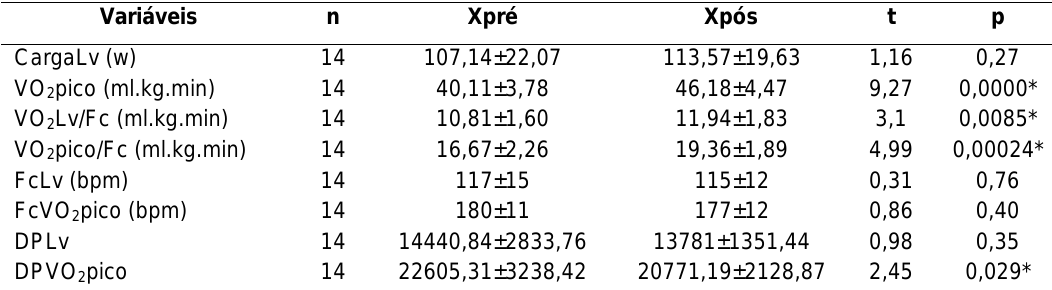
Tabela 1. Valores médios e desvio padrão das variáveis relacionadas ao desempenho aeróbio dos